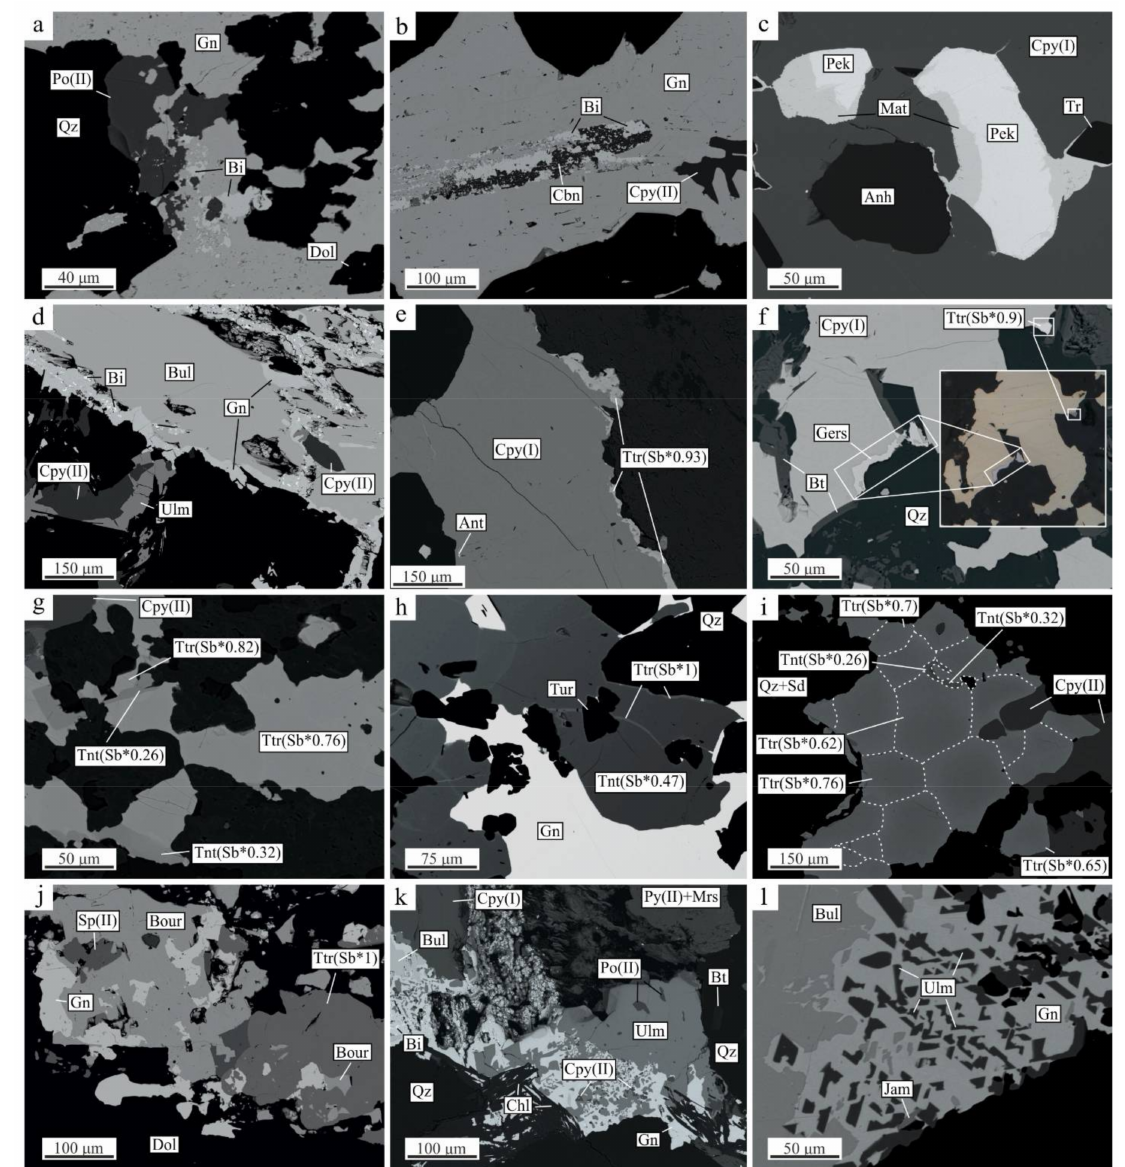
Figure 12. Backscattered electron micrographs showing relationships of ore minerals at the Kultuma deposit. ( a ) intergrowths of the galena and pyrrhotite; ( b ) chalcopyrite, cubanite and native bismuth microinclusions in galena; ( c ) pekoite grains were partially replaced by matildite; ( d ) galena devel- oped on the edges of the boulangerite aggregate; ( e ) chalcopyrite wads replaced on the edges of the grains by tetrahedrite; ( f ) tetrahedrite and gersdorffite developed on the edges of the chalcopy- rite aggregate; ( g ) intergrowths of the tetrahedrite, chalcopyrite and tennantite; ( h ) tetrahedrite replaced tennantite on the grains edges and by microfractures; ( i ) tetrahedrite aggregate with heterogeneous structure; ( j ) intergrowths of the tetrahedrite, bournonite, galena and sphalerite; ( k ) early chalcopyrite in association with boulangerite, galena, ullmannite and late chalcopyrite in zone of propylitic alteration; ( l ) graphic-like (subgraphic) intergrowth of galena and